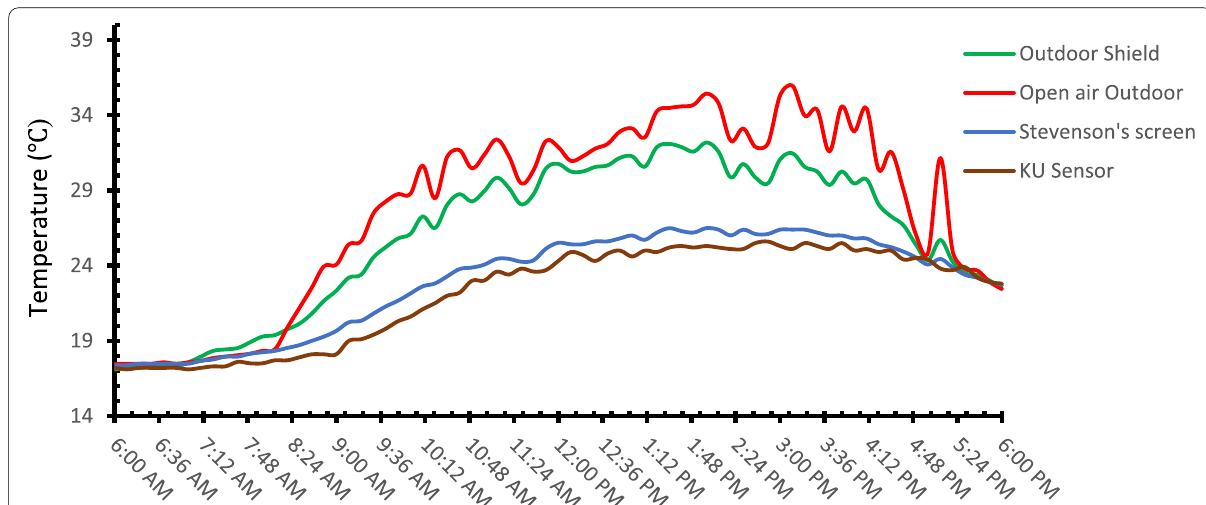
Fig. 9 Air temperature time-trends gathered from Hobo Pendant sensors (in Outdoor shield, Open air – unshielded, and in Stevenson’s screen) and an Envilog GP5W-Shell sensor (ecoTech, Germany) indicating differences in daytime sensor temperature records on 12/10/2020 between 6:00 AM to 6:00 PM. Temperature measured by unshaded HOBO Pendant (red line), shaded HOBO Pendant using fabricated radiation shield (green line), shaded HOBO Pendant using Stevenson’s screen (blue line), and shaded using Envilog GP5W-Shell radiation shield (brown line) over the experimental